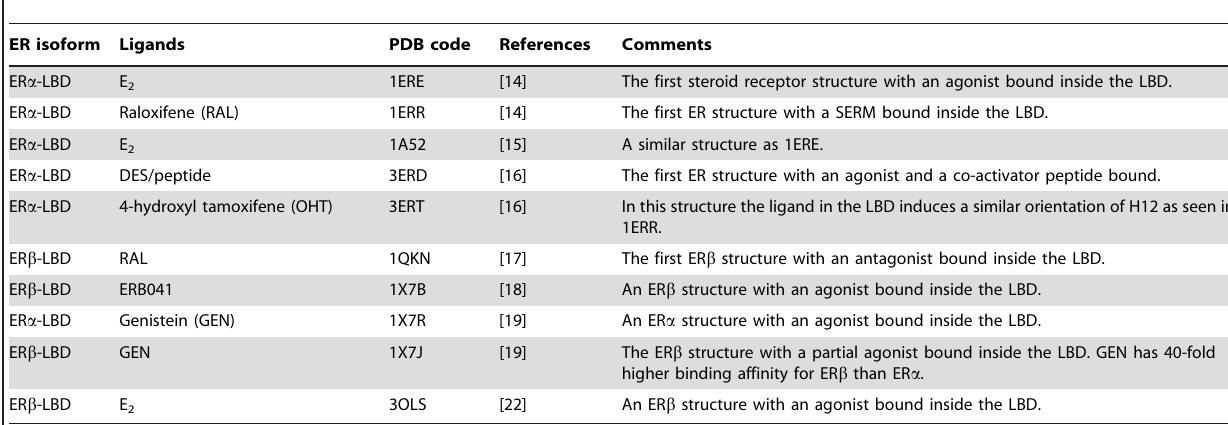
Table 2. Summary of current 3D structures of ERs in complex with various ligands (listed according to the chronological order of the publications).